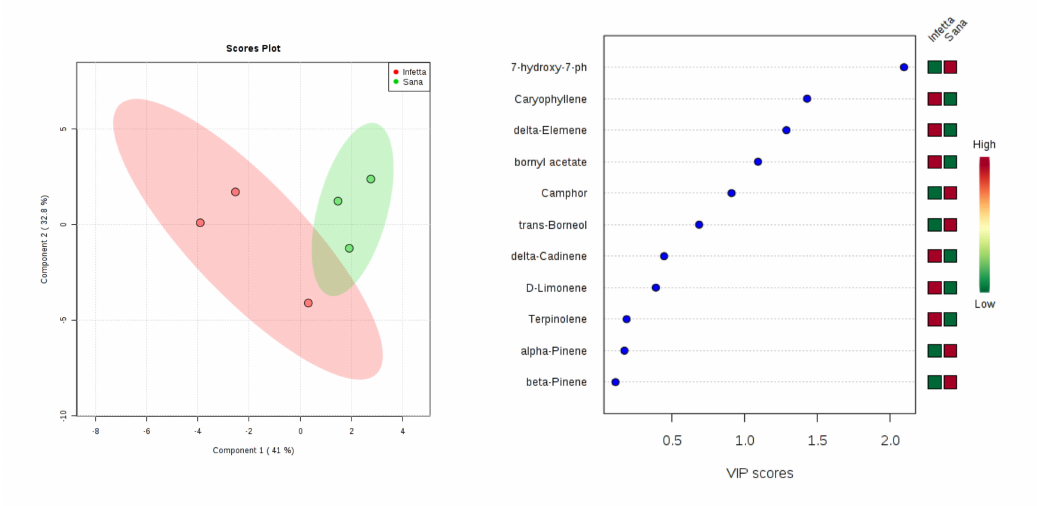
Figure 11. Partial least squares discriminant analysis applied to the Sampling #2 (DEFO-1) in Canolo. Parameters and symbols as in Figure